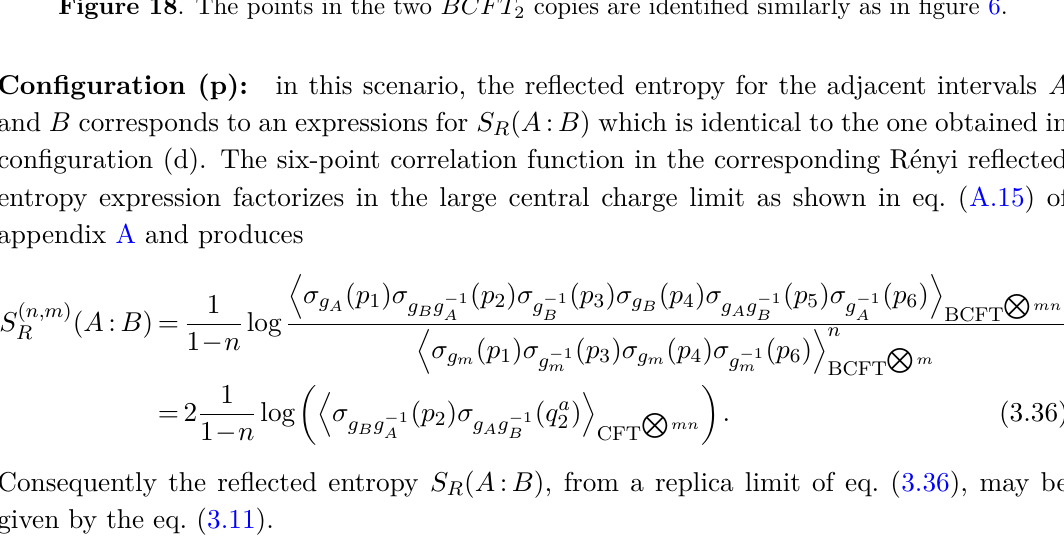
Figure 18 . The points in the two BCFT 2 copies are identified similarly as in figure